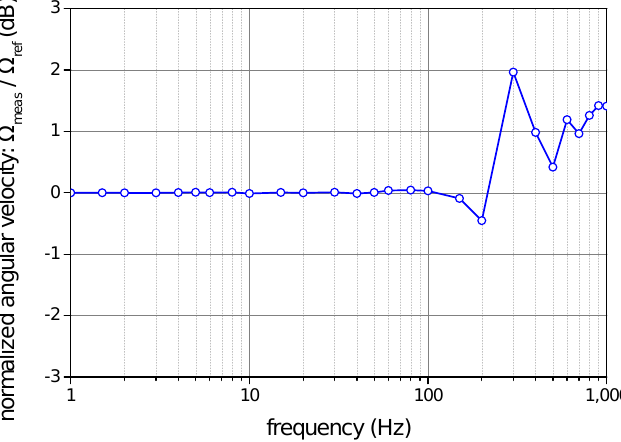
Figure 14. The frequency characteristics of the measured sine shape angular velocity at the calibration rotation table (the maximum closed-loop control rate was